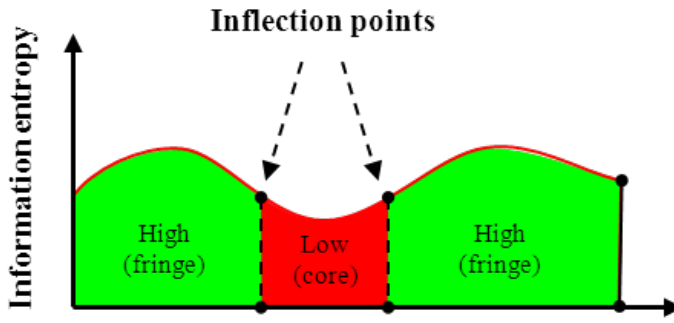
Figure 2. Inflection point recognition for information entropy analysis.